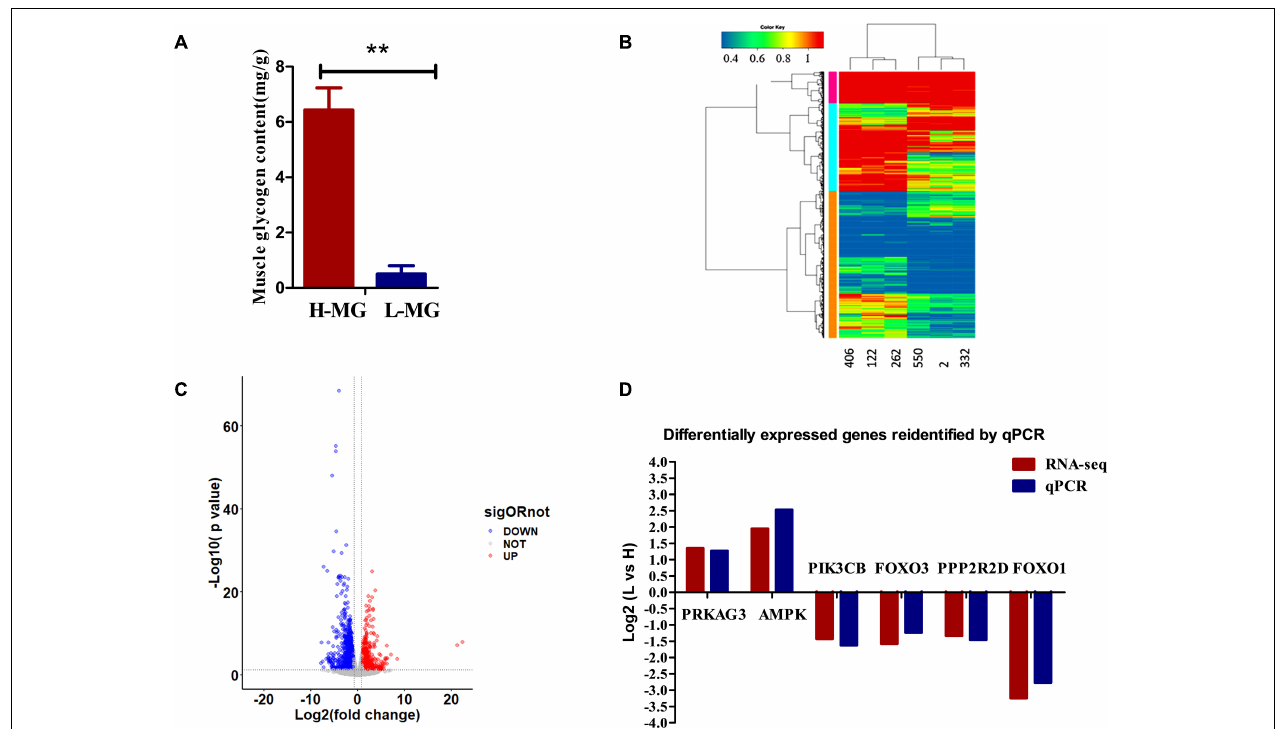
FIGURE 1 | The phenotypic analysis and the RNA sequencing analysis results. (A) The MG content in chickens from the HMG and LMG groups ( P = 0.0003). (B) Hierarchical clustering analysis. The hierarchical clustering analysis was performed based on DEGs; the heatmaps of all six samples revealed that the gene expression profiles in the same group were very similar. (C) Changes in gene expression profiles of Jingxing yellow (JX-Y) chicken from the HMG and LMG groups. Red dots represent upregulated genes, blue dots represent downregulated genes, and black dots (No) represent insignificantly DEGs. (D) Expression levels (fold change) of representative genes involved in MG metabolism pathways according to transcriptome analysis data of chickens from the HMG and LMG.